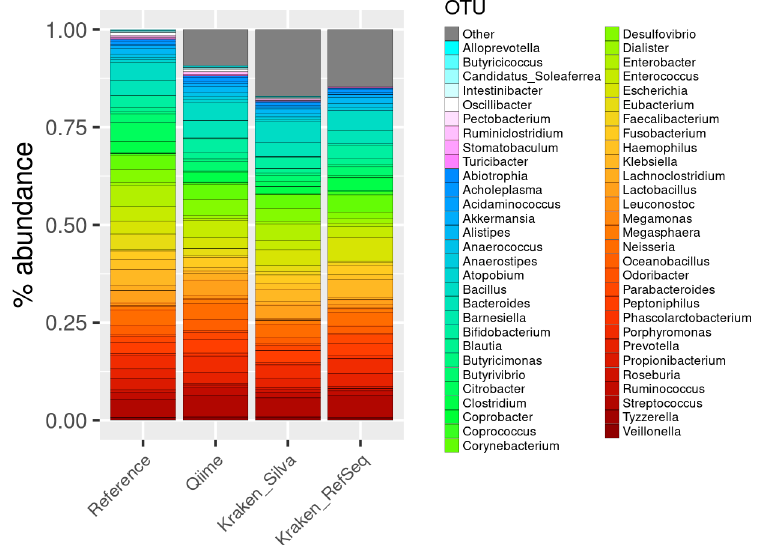
Figure 8. Stacked barplot depicting relative abundance between Reference abundance, QI- IME2, Kraken/Bracken pipeline with SILVA database and Kraken/Bracken pipeline with Gen- Bank repository in gut data from Almeida and collaborators dataset containing 58 genera and 500 species . Each vertical bar depicts the relative abundance according to Reference data, QIIME2 and Kraken/Bracken pipeline analysis (Kraken bar). Counts associated with false positive OTUs are coloured in grey. A different colour palette was used to represent the reference species not detected by any pipeline. The list of OTUs in the legend is included in Supplementary Table S5.